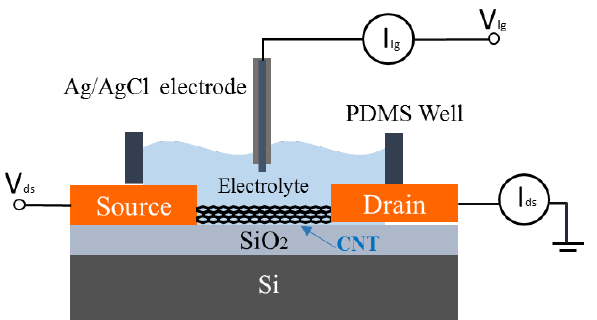
Figure 1. Schematic of the experimental setup for the electrical characterisation of a CNT FET and aptamer-functionalized CNT FET